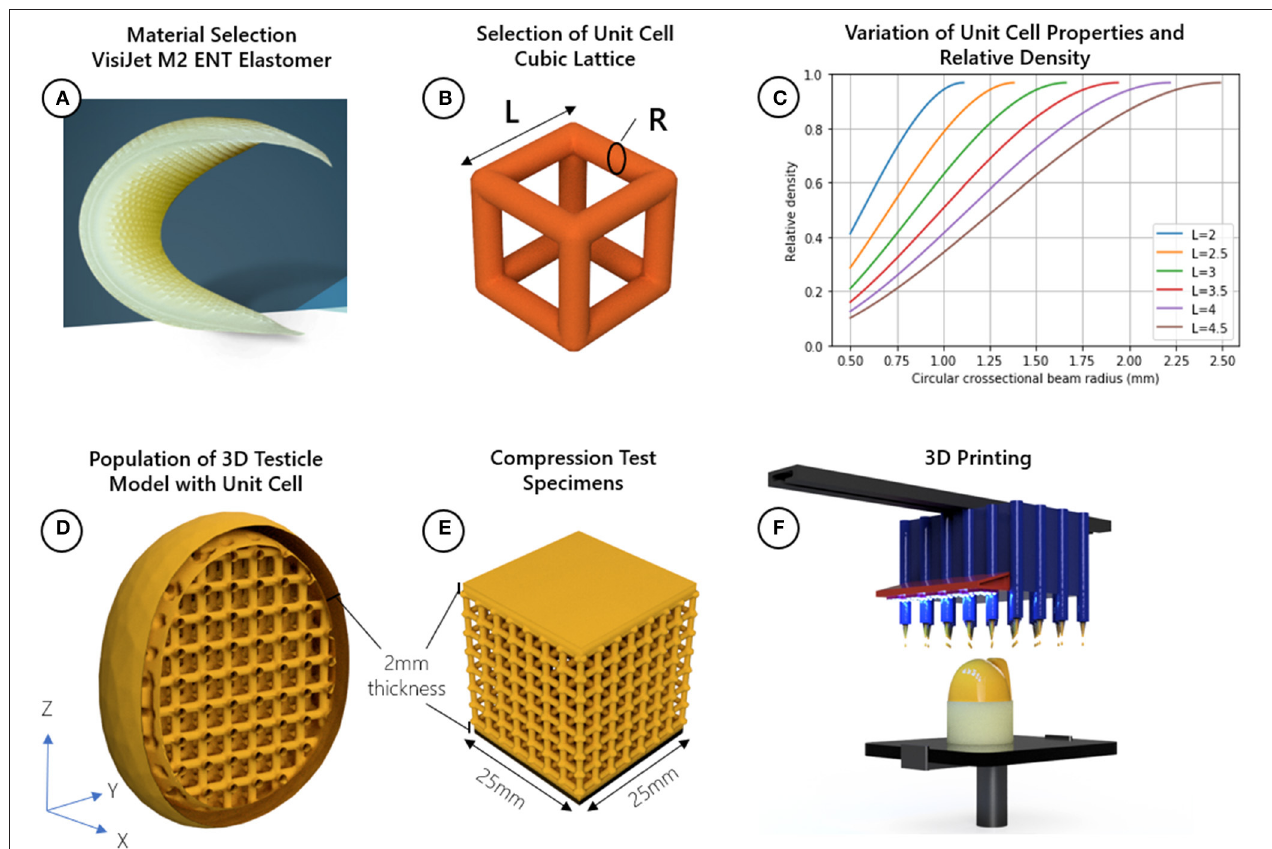
FIGURE 1 | Method for designing testicular prostheses; (A) material selection, (B) selection of cubic lattice unit cell and identification of relevant design parameters related to relative density length (L) and radius (R), (C) Plot showing how the radius and length of the cubic unit cell beams can be adjusted to achieve a range of relative densities, choosing a radius, or length which is too small may not be manufacturable, while choosing values too large narrows the range of achievable relative densities, (D) populate 3D model of testicle with cubic unit cell, (E) create compression test specimens with uniform cross-sectional area (25 mm 2 ), (F) 3D print the testicles and compression specimens using a Multi-Jet